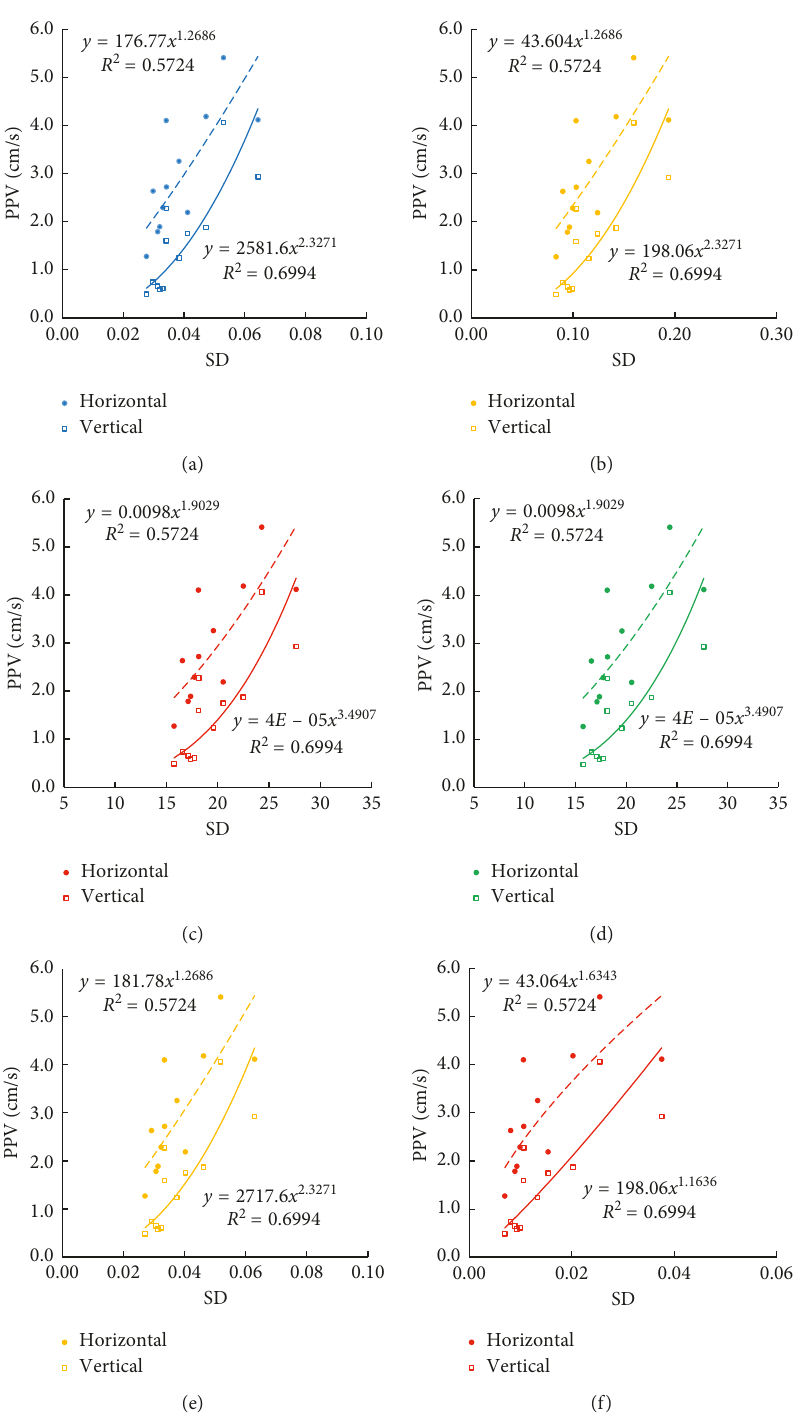
Figure 3: Data fitting results of different formulas. (a) By Sadaovsk formula. (b) By USBM formula. (c) By Indian formula. (d) By Sweden formula. (e) By Ambraseys–Hendron formula. (f) By Attewell formula. SD is the scaled distance; ln V means the logarithm of PPV; and lnSD is the logarithm of